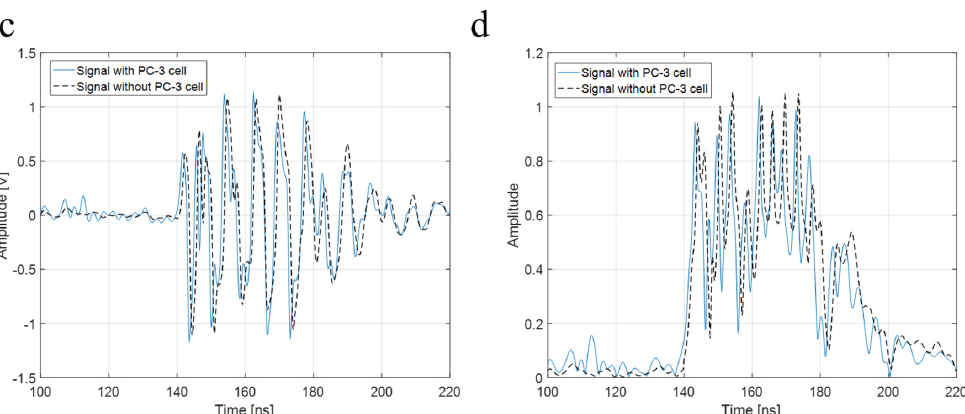
Figure 9. ( a ) Raw signal from the center with and w/o 15 μ m bead with a 410 MHz transducer, ( b ) signal after Hilbert transform from the center with and w/o 15 μ m bead with a 410 MHz transducer, ( c ) raw signal from the center with and w/o a PC-3 cell with a 410 MHz transducer, and ( d ) signal after Hilbert transform from the center with and w/o a PC-3 cell with a 410 MHz transducer.